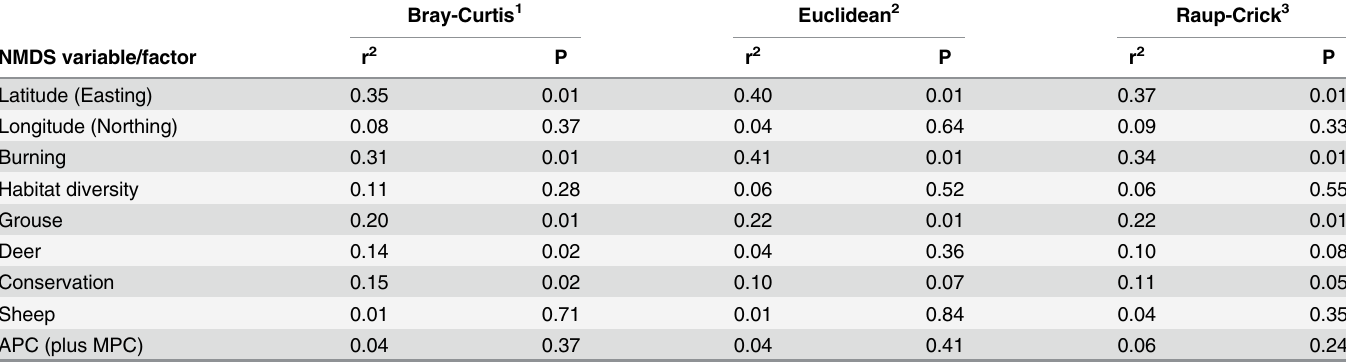
Table 4. Results of permutation tests on the effects of management objective and management practices on the composition of avian